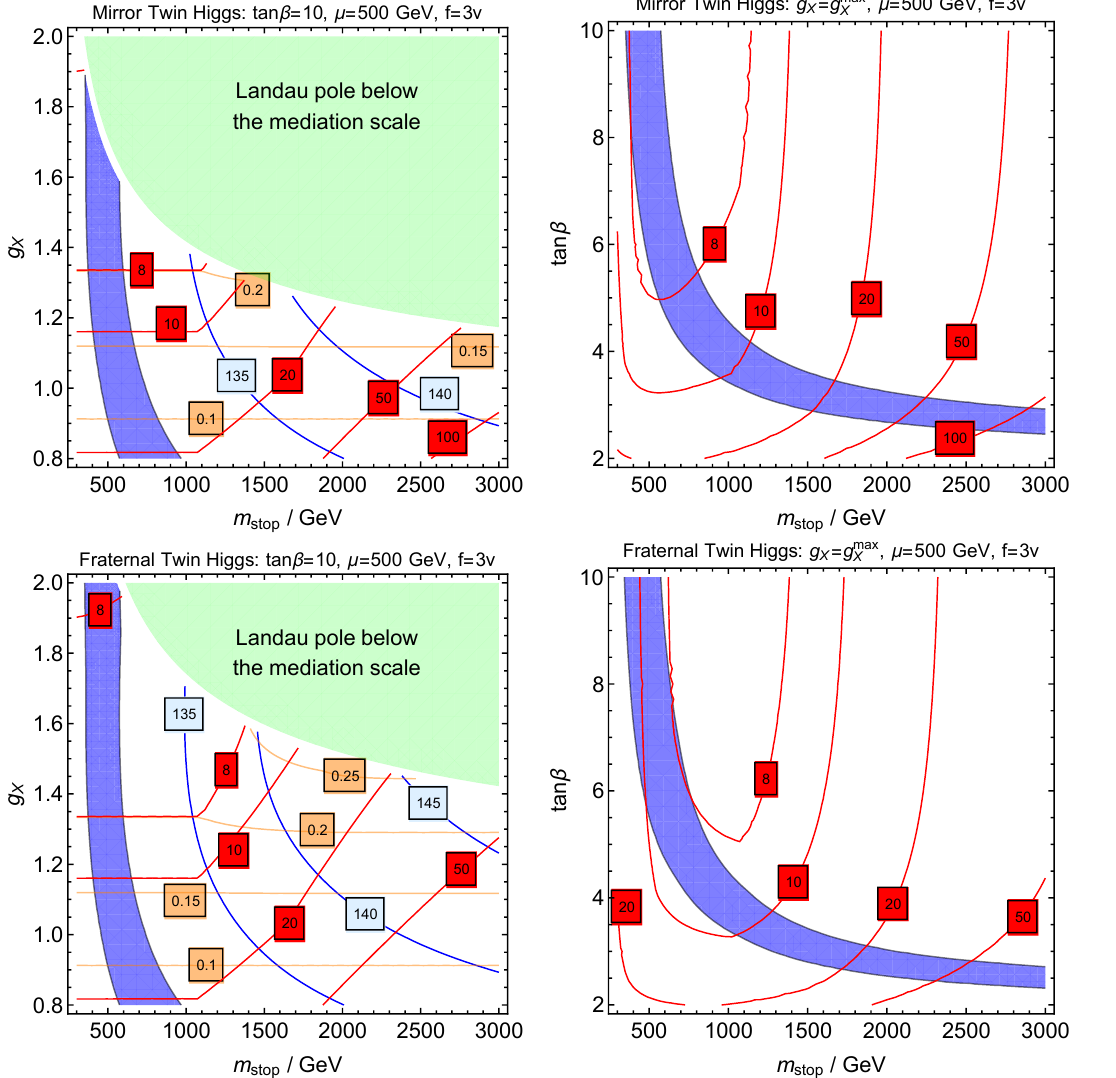
Figure 4 . Fine-tuning (red contours) in the D -term Twin Higgs model for f = 3 v , (cid:22) = 500 GeV, m A = 1 TeV and M 3 = 2 TeV assuming the messenger scale (cid:3) = 100 m stop . In the left panels, where tan (cid:12) = 10, the orange contours depict the value of the SU(4) preserving quartic coupling and in the green regions the Landau pole of the U(1) X gauge coupling constant is below (cid:3). In the right panels, at each point of the plane m stop -tan (cid:12) , g X is (cid:12)xed to the maximal value that allows the messenger scale to be below the Landau pole. In the blue region the Higgs mass is in agreement with the measured value and several blue contours of the Higgs mass are also shown. In the top (bottom) panels mirror (fraternal) Twin Higgs model is assumed.